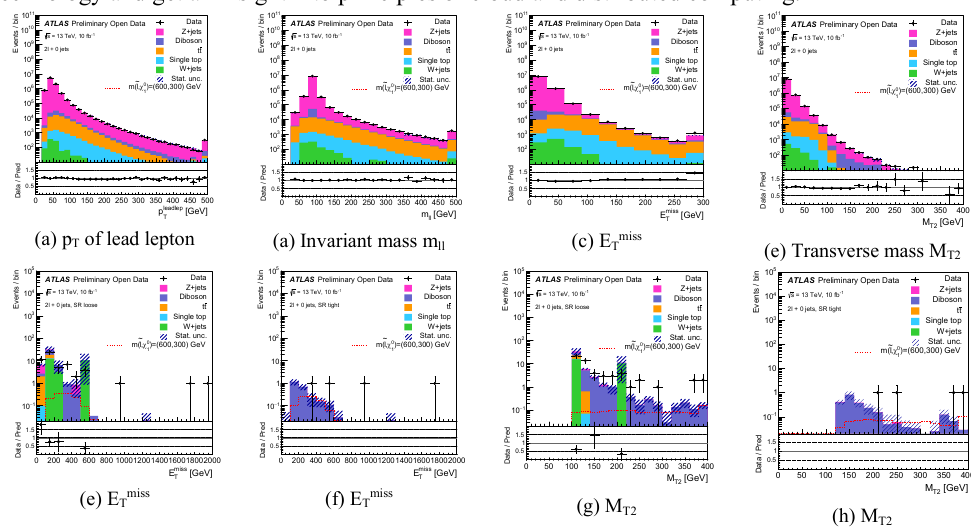
Figure 7. Comparison between data and MC prediction for several distributions in a final state with 2 leptons and missing transverse energy in a search for supersymmetric